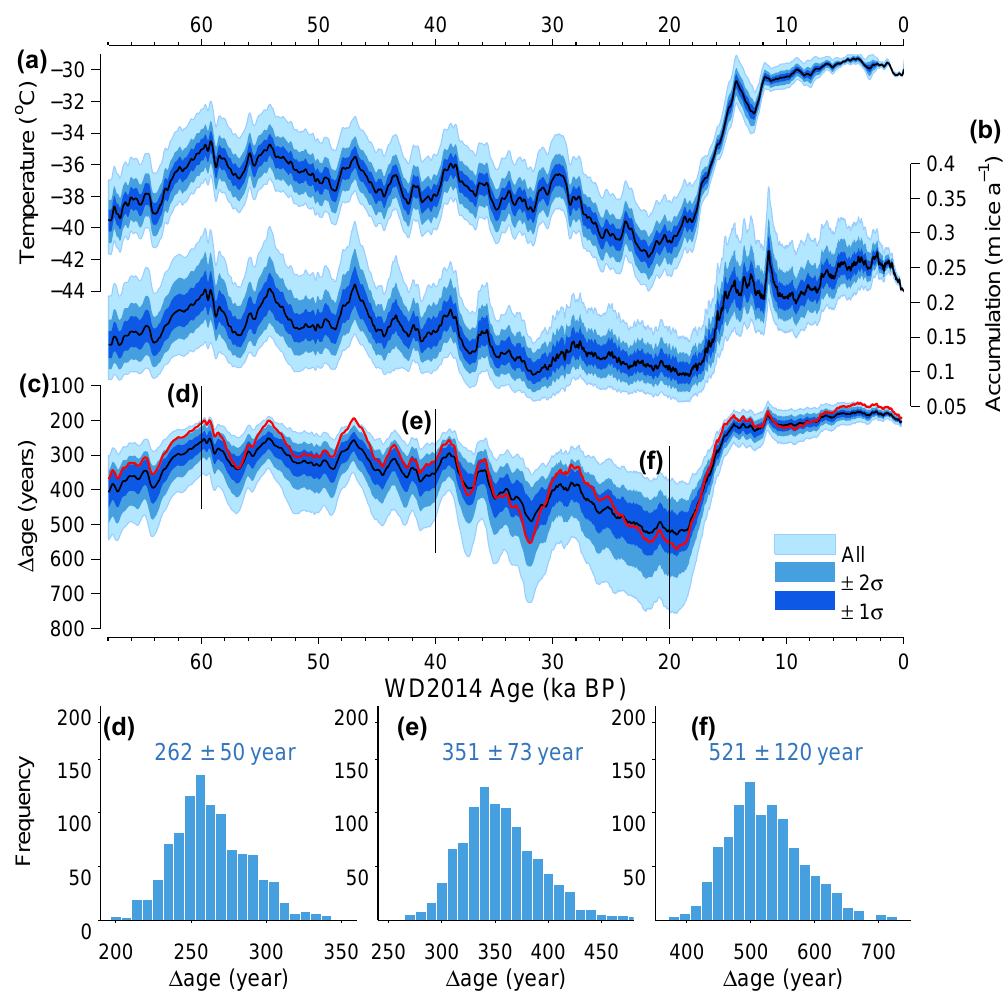
Figure 3. (cid:49) age sensitivity study. Shades of blue give the confidence intervals as marked; the black curves represent the values used in the WD2014 chronology; the red curve gives an alternative (cid:49) age solution using the Arnaud densification model. (a) Temperature forcing of